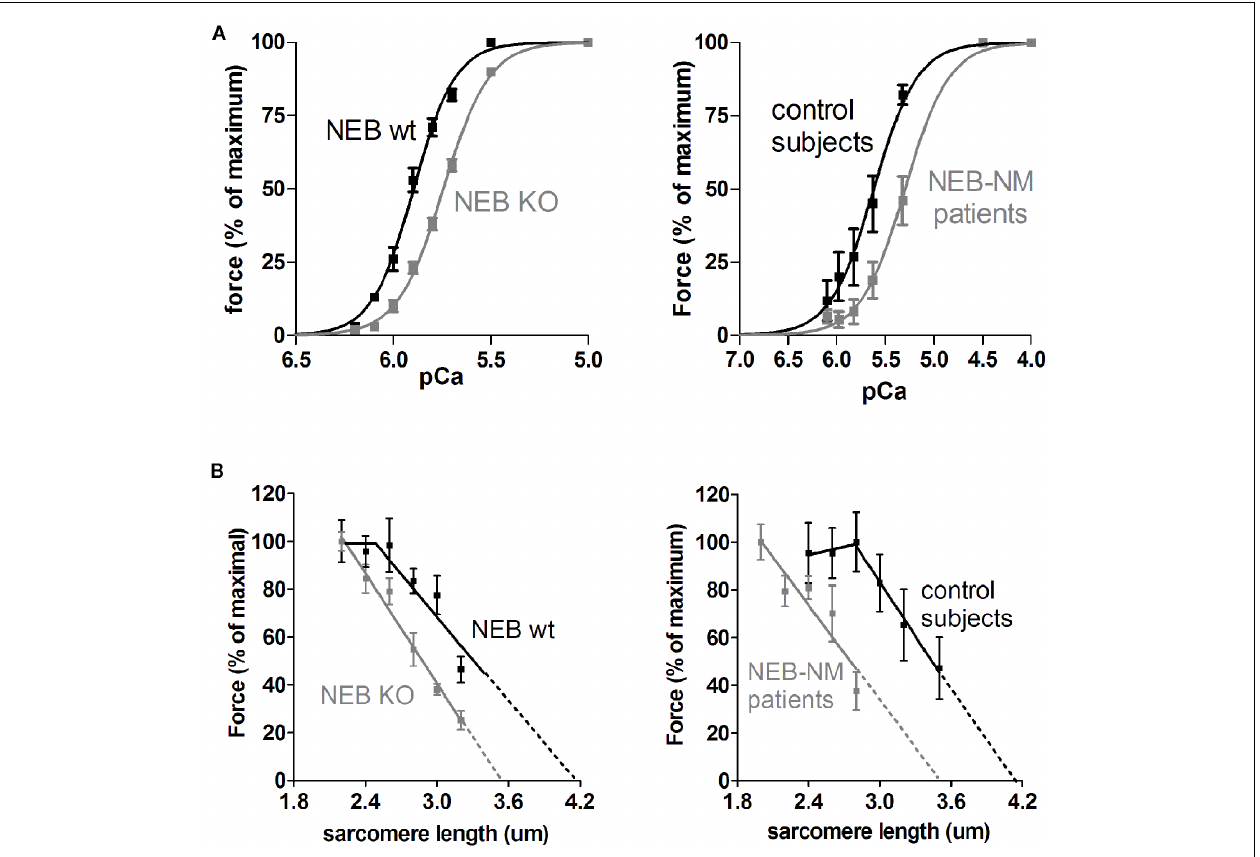
FIGURE 2 | (A) Force–Ca 2 + characteristics of murine skinned nebulin-deficient muscle fibers from m. tibialis cranialis (NEB-KO, left panel), and of skinned muscle fibers from m. quadriceps of patients with nebulin-based nemaline myopathy (NEB-NM, right panel). Note that the force generated in response to incubation with incremental increase of [Ca 2 + ] is significantly decreased in both NEB-KO and NEB-NM tissue, resulting in a rightward shift of the force–Ca 2 + relationship (Figures adapted from Chandra et al., 2009;